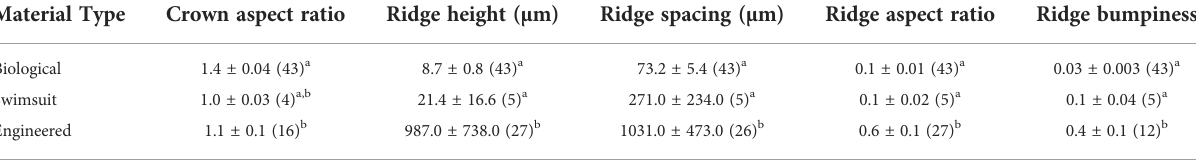
- Numbers in parentheses are sample sizes. - Columns with different letters are signi fi cantly